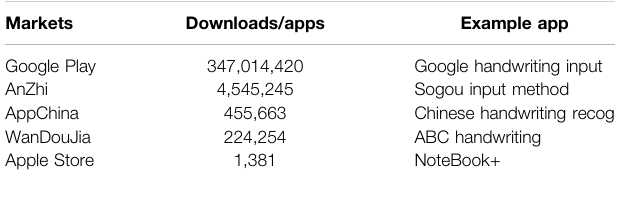
TABLE 1 | Survey of handwriting-related apps.